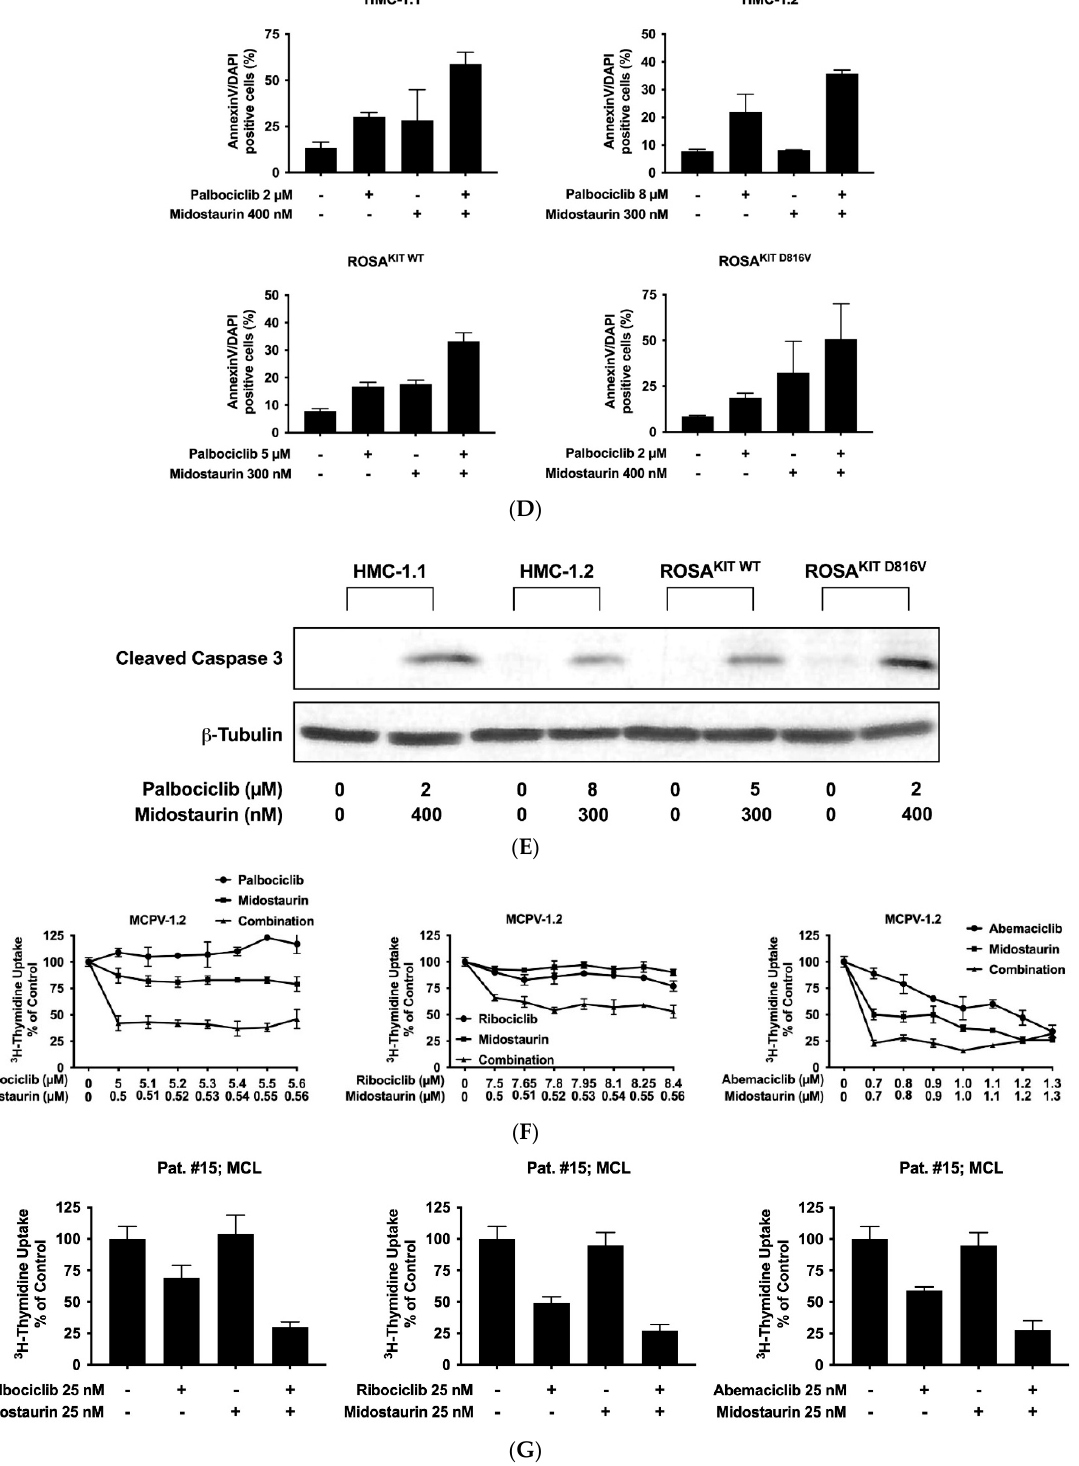
Figure 5. CDK4/CDK6 inhibitors synergize with midostaurin in counteracting proliferation in MC cell lines and primary neoplastic MC. ( A – C ) HMC-1 and ROSA cells were incubated with control medium (0 nM) or medium containing various concentrations of palbociclib ( A ), ribociclib ( B ) or abemaciclib ( C ) alone or in combination with midostaurin (as indicated) at 37 ◦ C for 48 h.